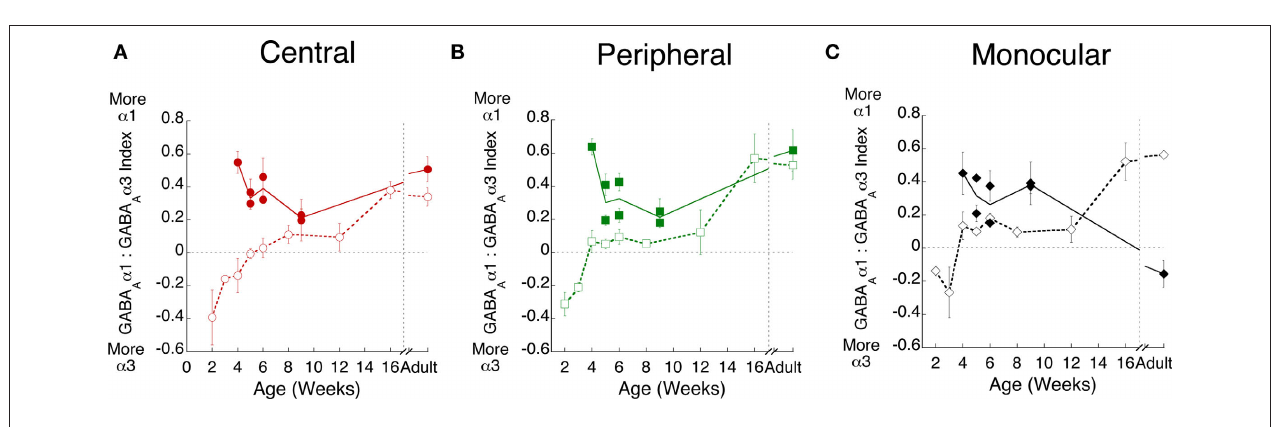
(filled symbols, solid lines) kittens in the (A) central (red circles), (B) peripheral α 1. A (green squares), and (C) monocular (black diamonds) visual field α 1:GABA α 3 index was A A